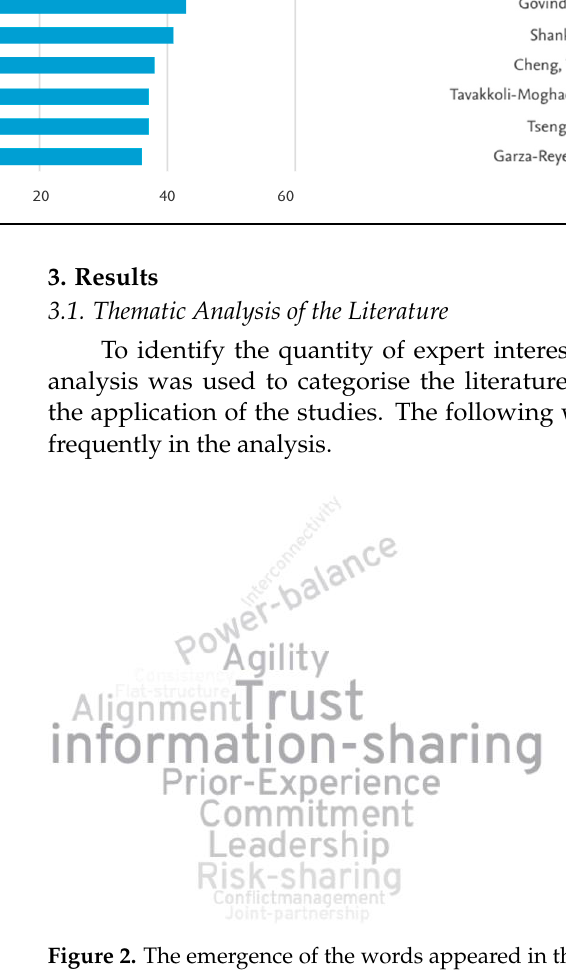
Table 4. The frequency of the main collaborative measures in the literature.